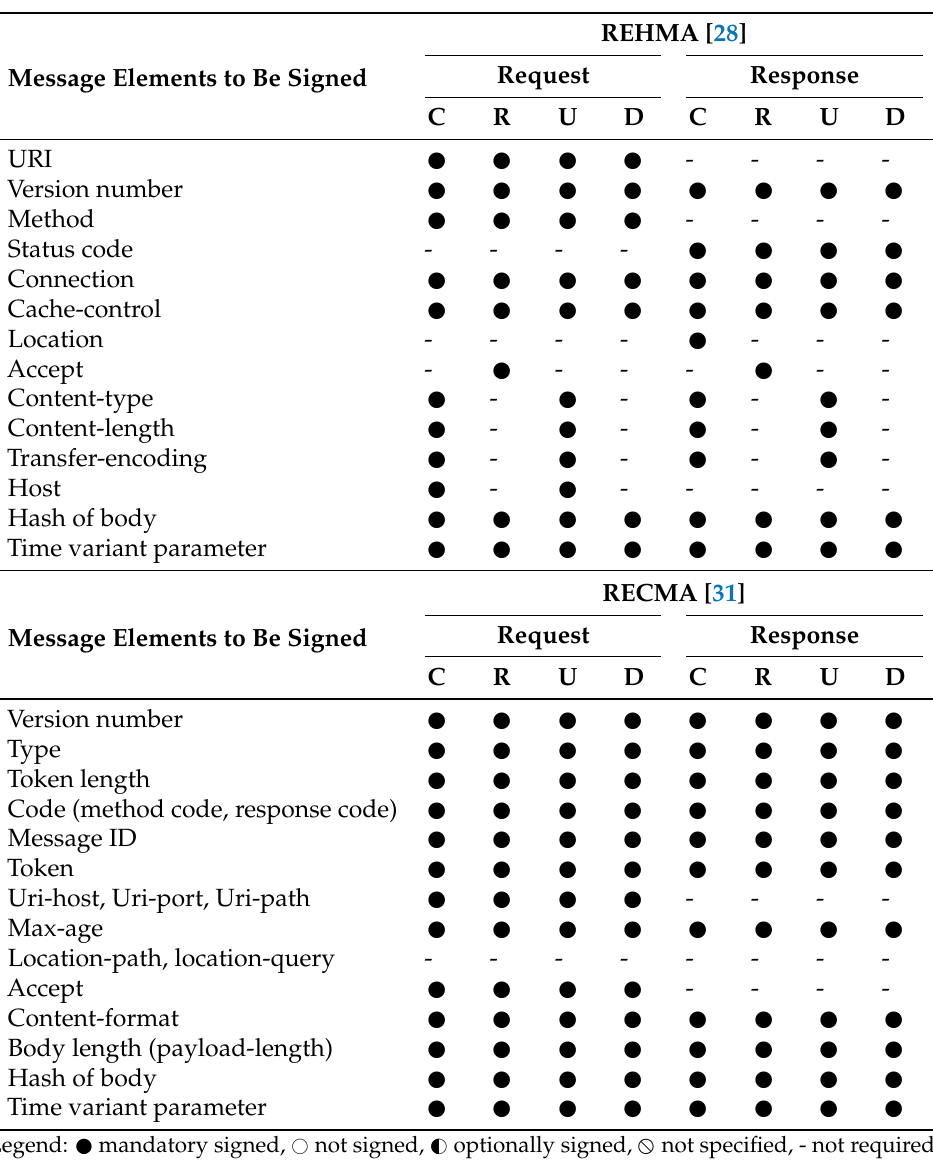
Table 4. To be signed message elements by REST-ful HTTP message authentication (REHMA) and REST-ful CoAP message authentication